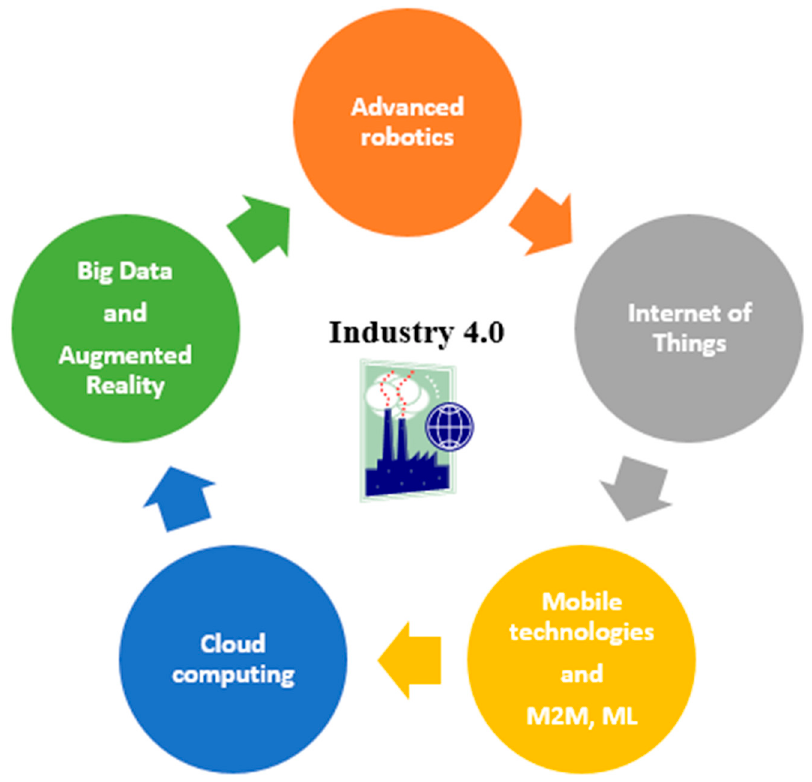
Figure 2. Idea of Industry